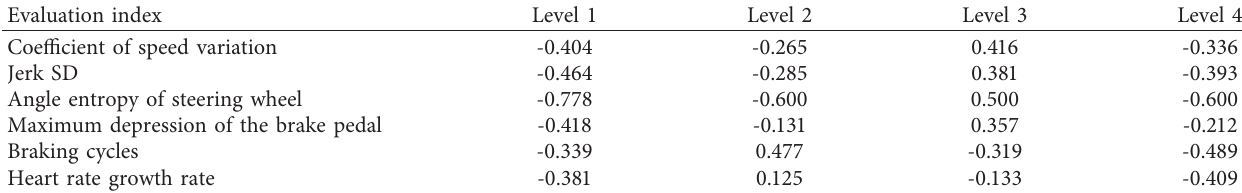
Table 4: Membership matrix.